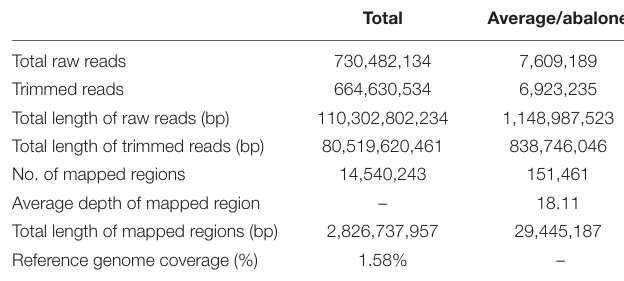
TABLE 2 | Overview of GBS sequence data for demultiplexing.